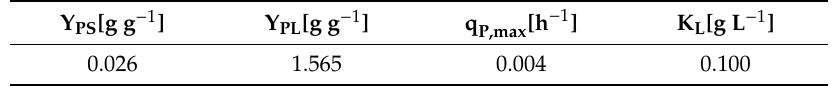
Table A22. Estimated model parameters for the yield coe ffi cient product / substrate Y PS, yield coe ffi cient product / inducer Y PL, maximum production rate product q P,max , and monod constant inducer K